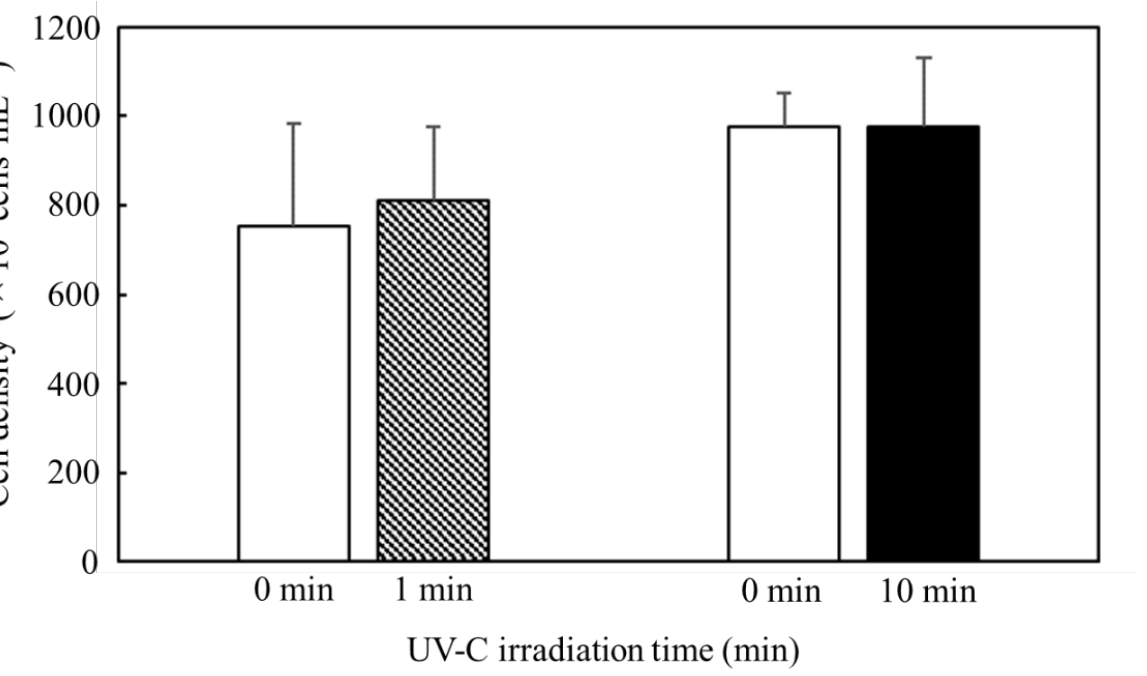
Figure 2. Effect of UV-C irradiation for cell burst. Cell densities before/after UV-C irradiation were quantified with a hemocytometer. The prepared cell densities were 4.8 × 10 6 ~1.2 × 10 7 cells · mL − 1 , and the cells were treated by UV-C irradiation. Error bars indicate the SD of three replicate experi- ments (n =